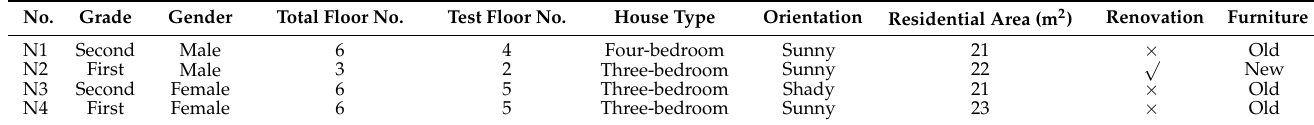
Figure 2. Plane structure of c graduate dormitory: ( a ) three-bedroom; ( b ) four-bedroom; ( c ) site situation. Table 1. Characteristics of residences and occupants for each case